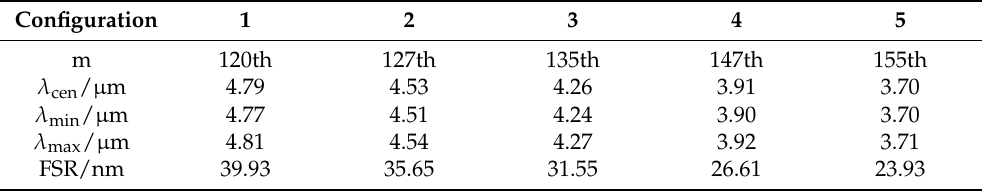
Table 4. The wavelengths and free spectral ranges of multiple configurations.